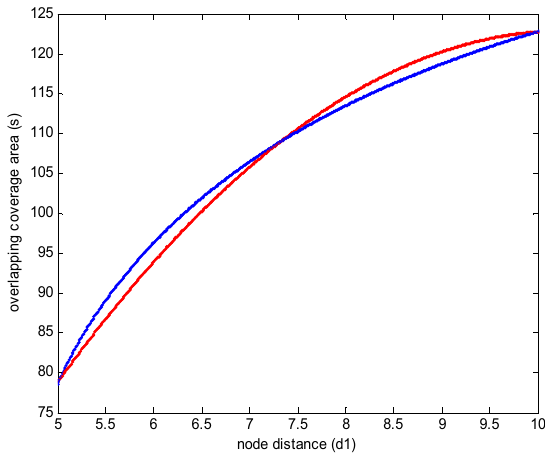
Figure 13. The fitting results of Equations (22) and (29).